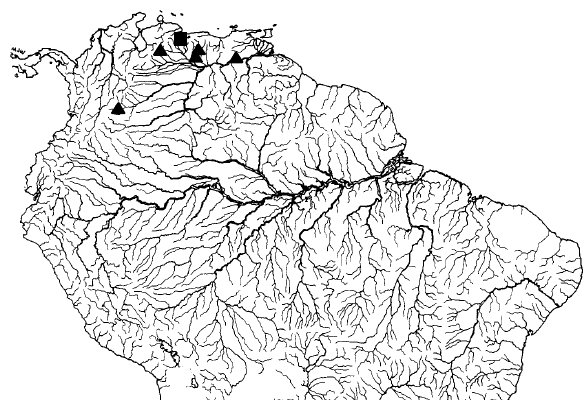
Fig. 22. Distribution of Odontostilbe splendida (triangles), and Odontostilbe pao (square). Symbols can represent more than one lot, and more than one